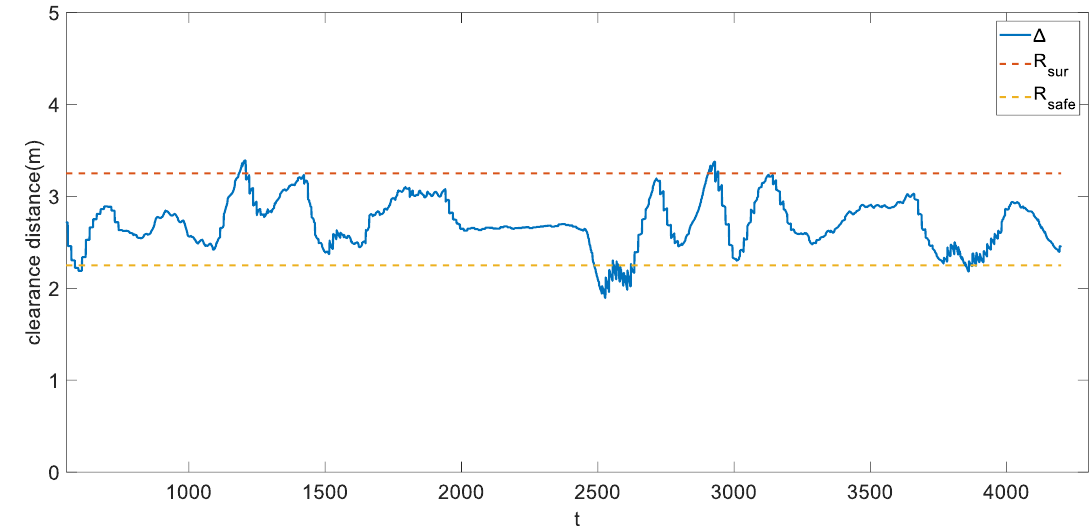
Figure 12. The clearance distance Δ (the relative gap between the UAV and dynamic target object) during the experiment.